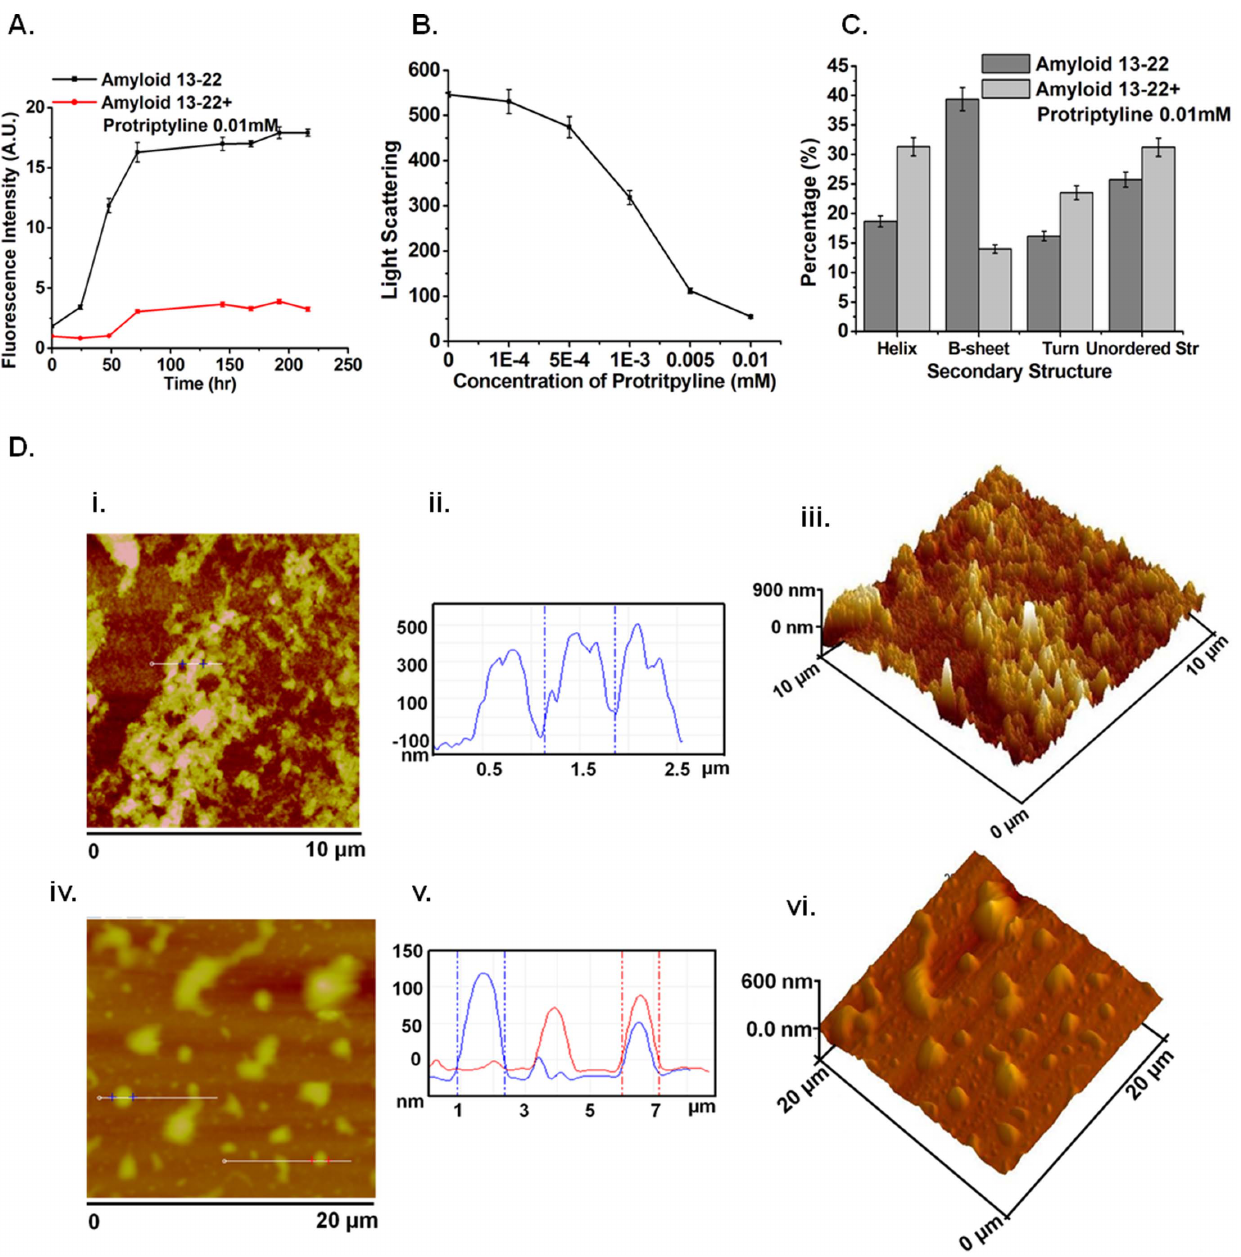
Figure 3. Inhibition of A b aggregation by protriptyline. A b 13–22 aggregation in the absence and presence of protriptyline was investigated by A . Thioflavin T assay B . Light scattering C . CD analysis D . Atomic Force Microscopy images [i and iv] of aggregated amyloid and Amyloid + protriptyline (0.010 mM) in 10 6 10 m m 2 and 20 6 20 m m 2 surface area respectively. It is also represented in Line profile [ii and v] and 3D images [iii and